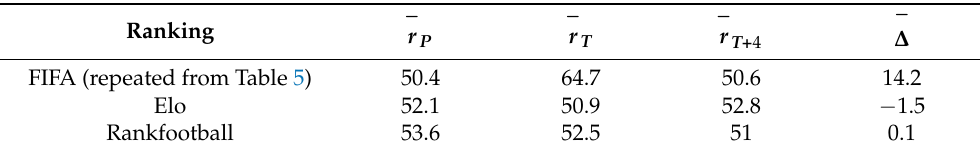
Table 7. The average positions and changes in the FIFA and two alternative rankings Elo and